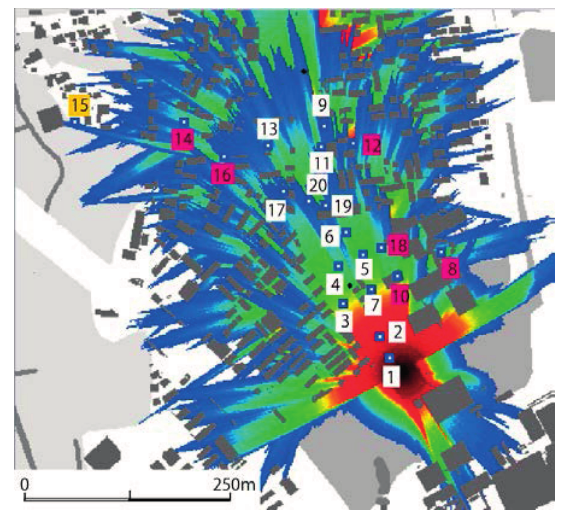
Figure 10. Experimental results of communication situation.